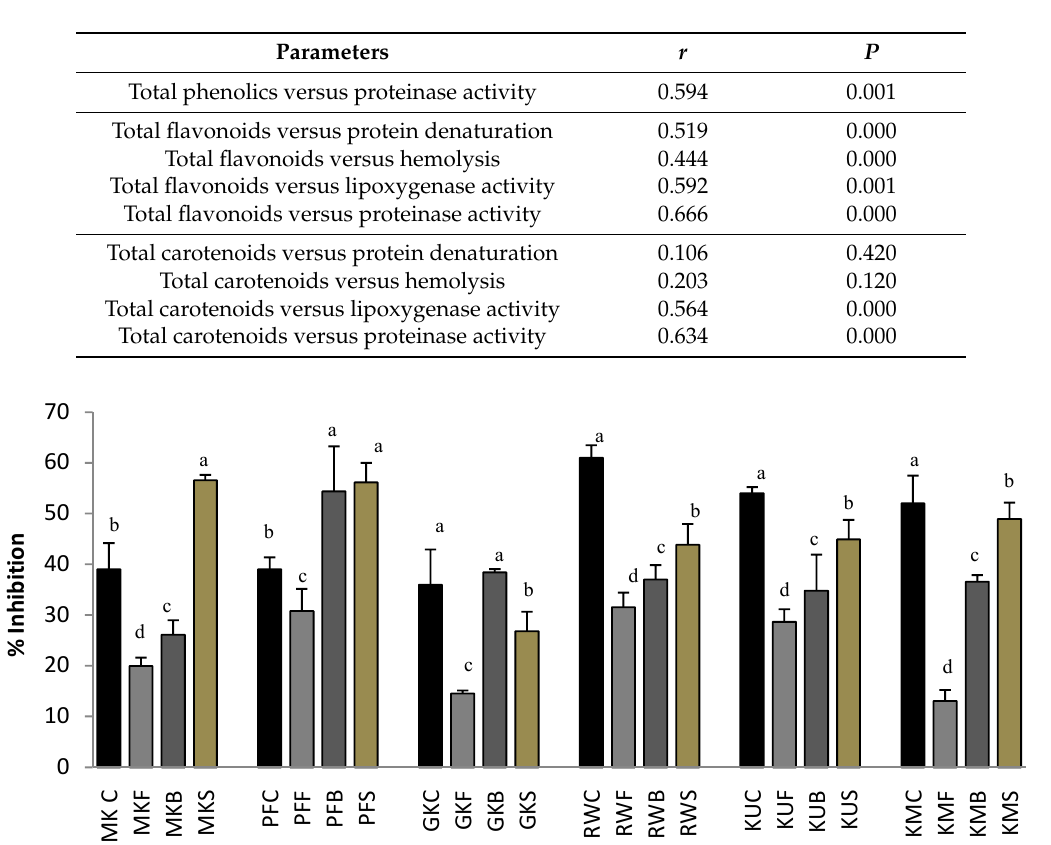
Figure 1. Protein denaturation inhibition ability of raw and cooked extracts of some GLV. MK, O. zeylanica ; RW, C. auriculata ; KM, S. grandiflora ; KU, G. lactiferum ; PF, P. edulis ; GK, C. asiatica . C-fresh leaves; F-fried; B-boiled; S-steamed. Data are presented as means ± standard deviations of three replicate determinations. Columns with different letters for each vegetable are significantly different ( p < 0.05).